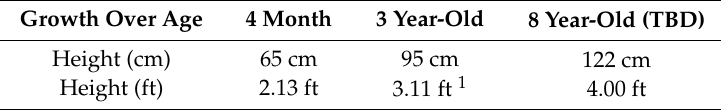
Table 1. Degree of robot growth over age (example). Adapted from